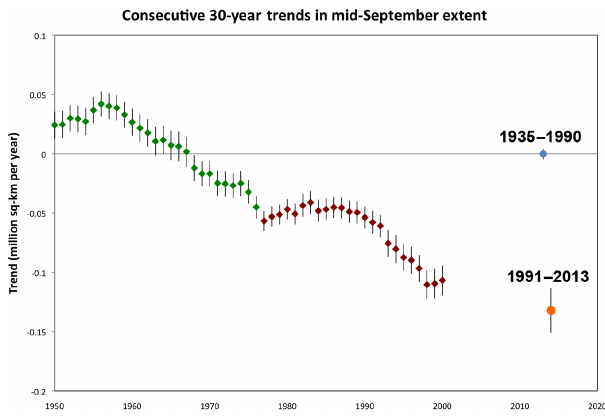
Figure 7. Consecutive 30-year trends of mid-September SIE in the Arctic Basin. The first green symbol shows the 30-year trend be- tween 1935 and 1964 and is plotted at the center year in 1950. The next value in 1951 shows the trend for 1936–1965, and so on. The last green symbol in 1975 is for the 1961–1990 trend. The red sym- bols show trends after 1990, ending with the 1984–2013 trend. The blue symbol shows that the 1935–1990 trend was zero, and the or- ange symbol shows the trend from 1991 to 2013. SIE values are obtained from Walsh et al.